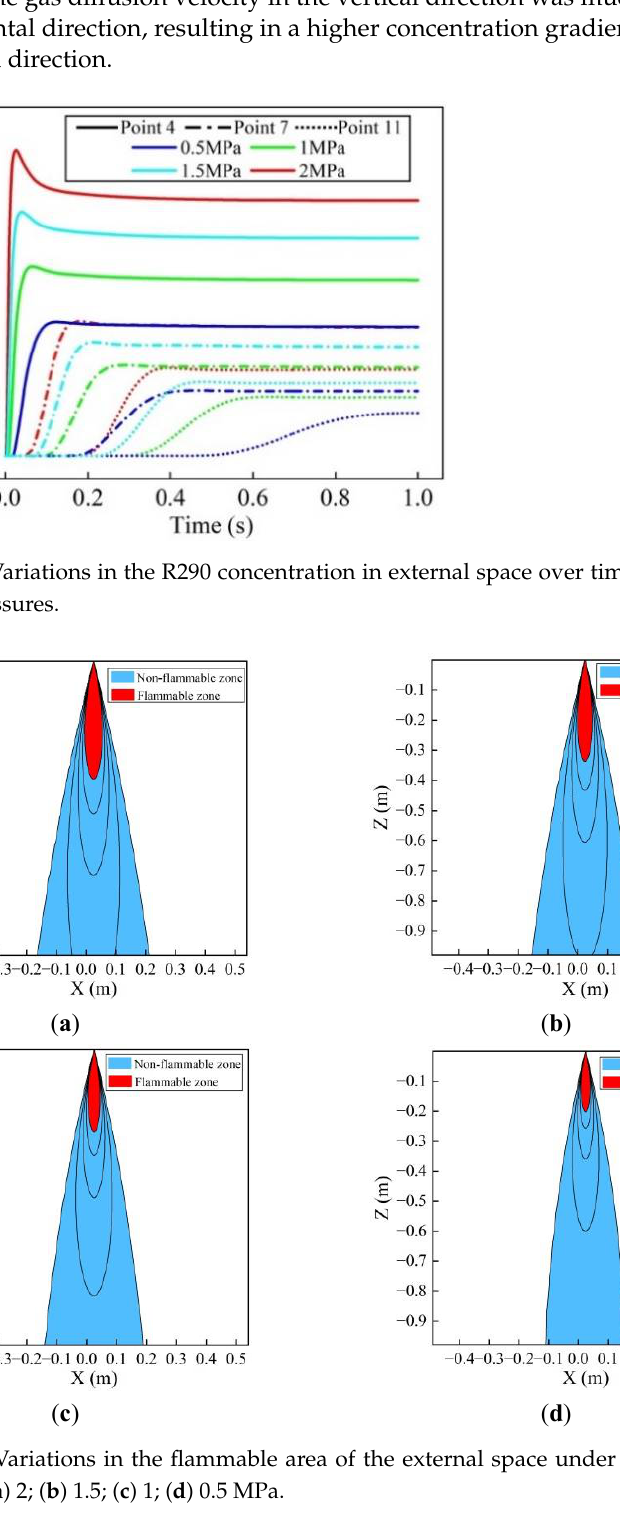
Figure 14. Variations in the flammable area of the external space under different initial leakage pressures: ( a ) 2; ( b ) 1.5; ( c ) 1; ( d ) 0.5 MPa.